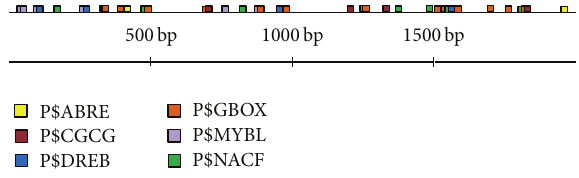
Figure 5: Distribution of stress-related cis -acting elements in the 2,000 bp promoter region of OsSLI1. Different cis -elements for TFs were labeled with different colors. Right end 2,000 bp is the transcriptional start site (TSS) of OsSLI1.